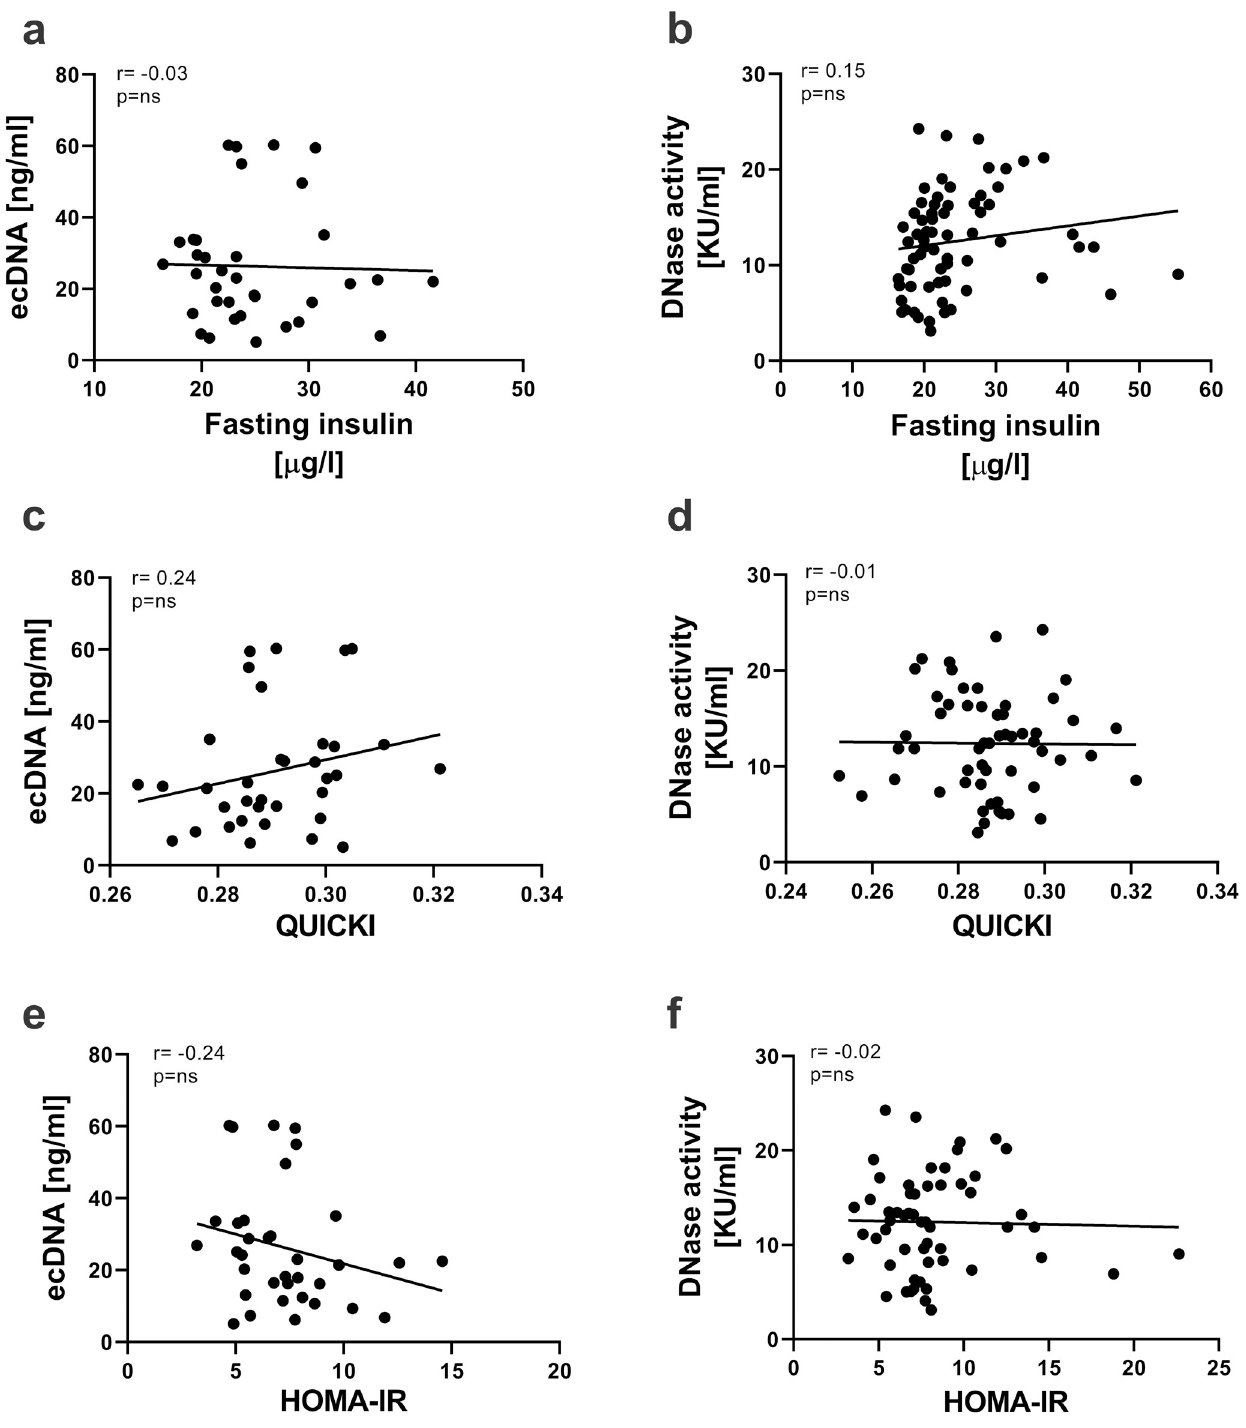
Fig 3. Relationship of ecDNA and DNase activity with fasting insulin, QUICKI and HOMA-IR. Correlations between ecDNA and fasting insulin (a), QUICKI (c) or HOMA-IR (e). Correlations between DNase activity and fasting insulin (b), QUICKI (d) or HOMA-IR (f). ecDNA. ecDNA—extracellular DNA; HOMA-IR—Homeostatic Model Assessment of Insulin Resistance; QUICKI -Quantitative Insulin Sensitivity Check Index; KU—Kunitz units.